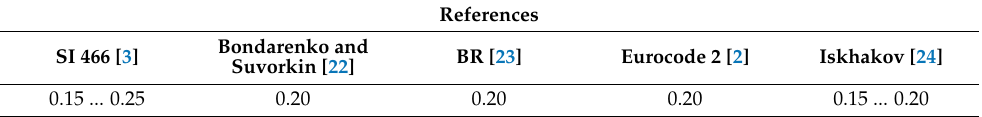
Table 4. Poisson’s ratios.